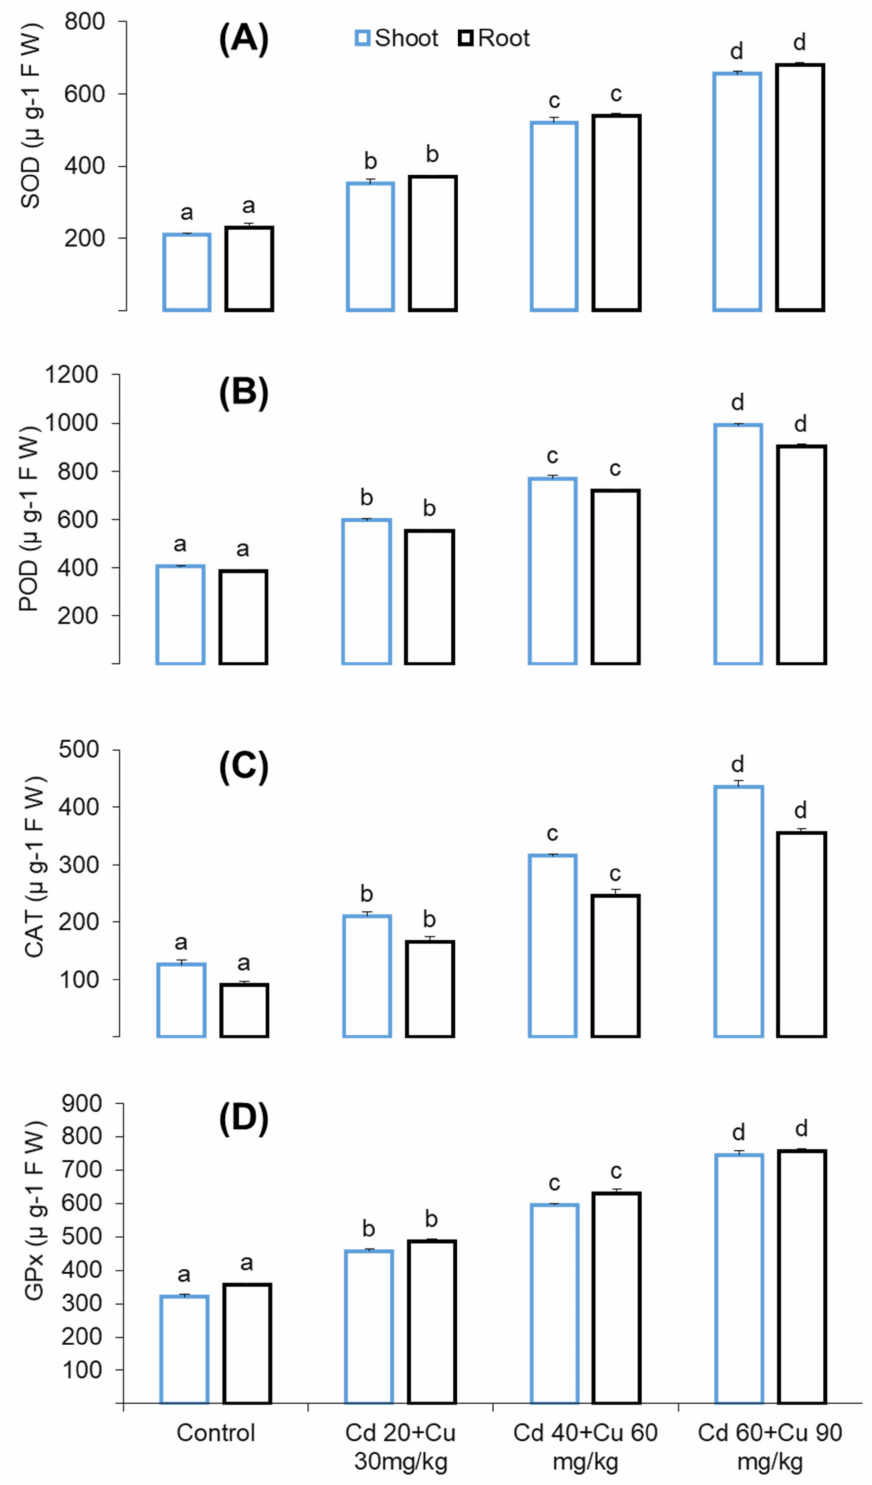
Figure 4. The effect of different cadmium and copper concentrations (0, Cd 20 + Cu 30 mg/kg, Cd 40 + Cu 60 mg/kg, and Cd 60 + Cu 90 mg/kg) on shoots and roots’ antioxidant enzymes, namely, SOD ( A ), POD ( B ), CAT ( C ), and GPX ( D ) contents in pigeon pea plant. Bars represent means from the three independent replicates ( ± , n = 3); different letters indicate significant differences between the treatments at p <